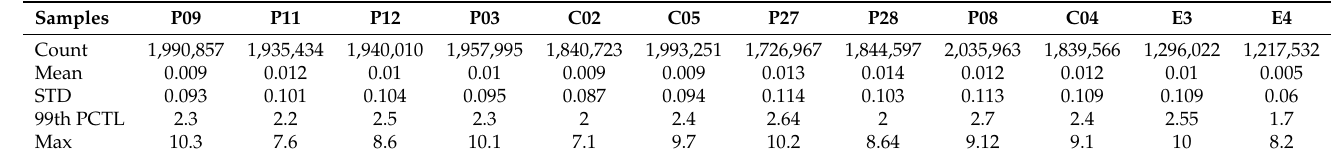
Table 1. Statistical description of raw data from EPMAPS and SADMQ , including the total amount of non-null samples, mean, standard deviation maximum values, and the the 99th percentile (PCTL) for values greater than